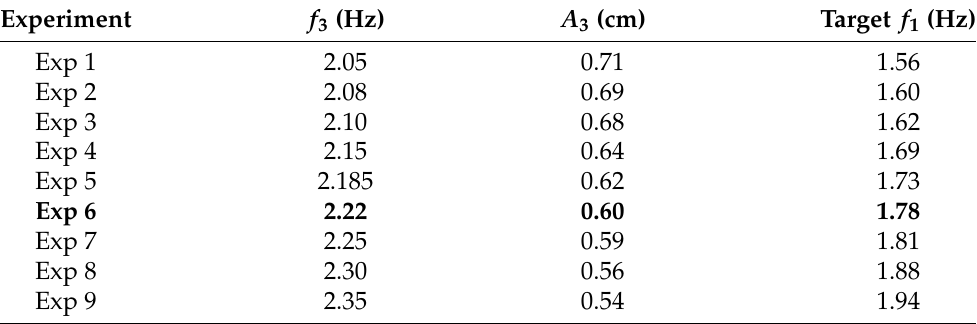
Table 1. For each experiment, frequency f 3 along with the wavemaker oscillation amplitude A 3 , chosen so that A 3 K 3 ≈ 0.12, where K 3 = 4 π 2 g − 1 f 2 is the wavenumber. In the last column, the 3 (cid:112) gK 1 /2 π that would be observed if wavenumber K 1 = K 3 − K 2 theoretical target frequency f 1 = was produced. We highlight in boldface the resonant case f 1 : f 2 : f 3 = 4 : 3 : 5, corresponding to Equation